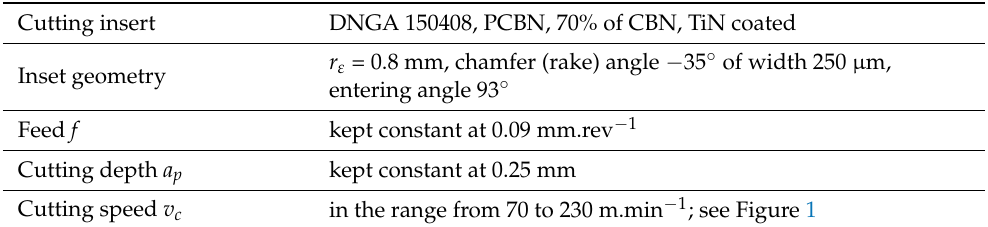
Table 1. Cutting inserts and cutting conditions.